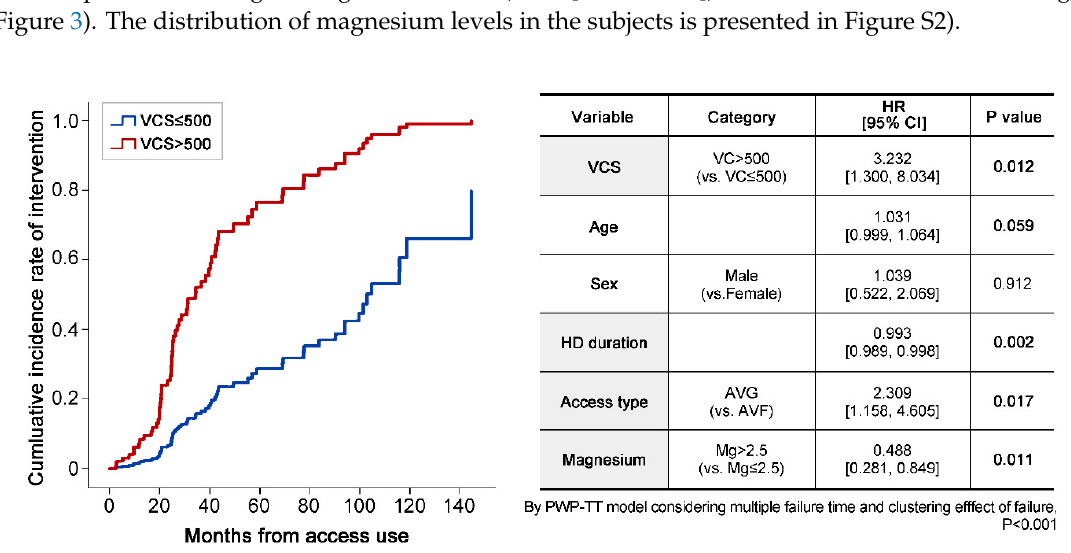
Figure 3. Incidence of interventions in the two VCS groups.